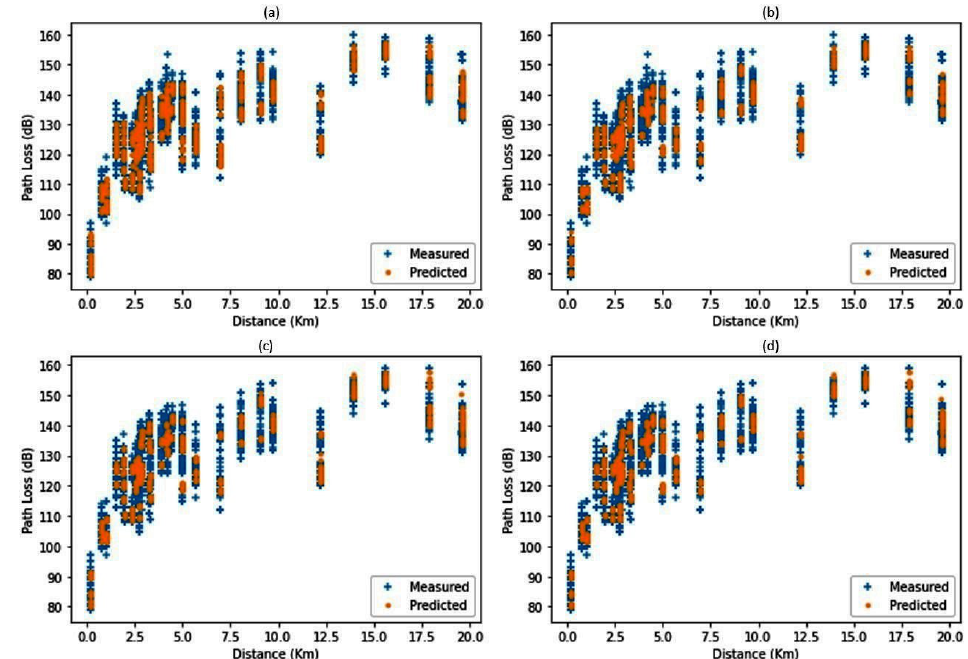
Figure 16. Predictions in rural environment based on ( a ) DRS on dataset 1, ( b ) DES on dataset 1, ( c ) DRS on dataset 2, ( d ) DES on dataset 2.